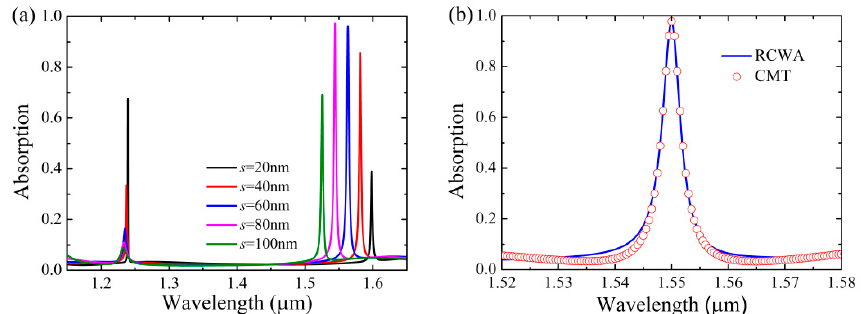
Figure 5. Absorption response of the Si-based PCS with graphene, other parameters are the same as Figure 2. ( a ) Absorption response as a function of the slit width s . ( b ) Rigorous coupled-wave analysis (RCWA) result and coupled mode theory (CMT) result of absorption response with s = 74